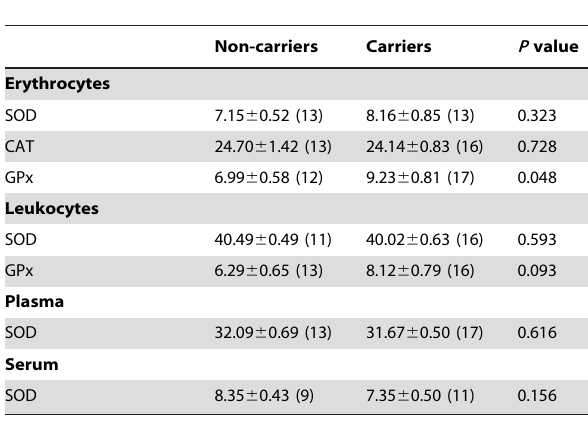
Table 2. Antioxidant enzyme activities in blood from TP53 p.R337H mutation carriers and